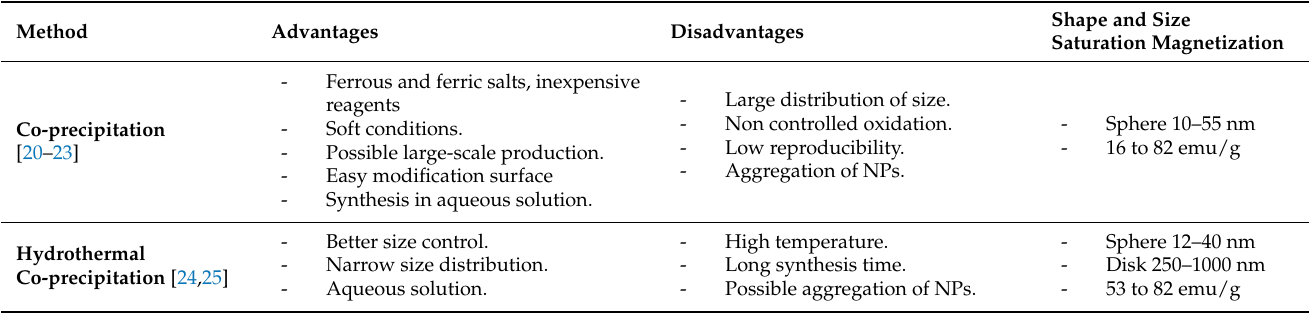
Table 2. Summary of advantages, disadvantages and morphological characteristics and saturation magnetization of the magnetic iron oxide nanoparticles synthesized by the main synthesis